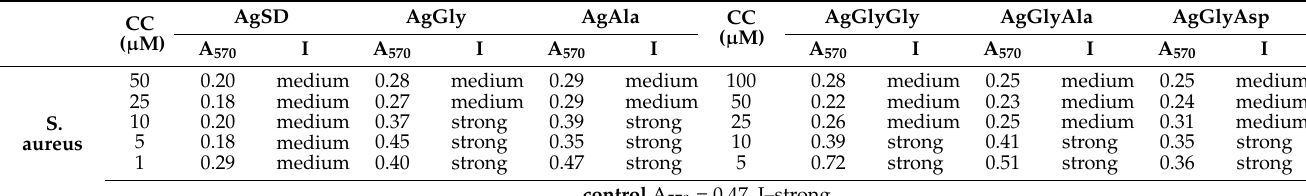
Table 3. The influence of silver(I) complexes on S. aureus biofilm formation.